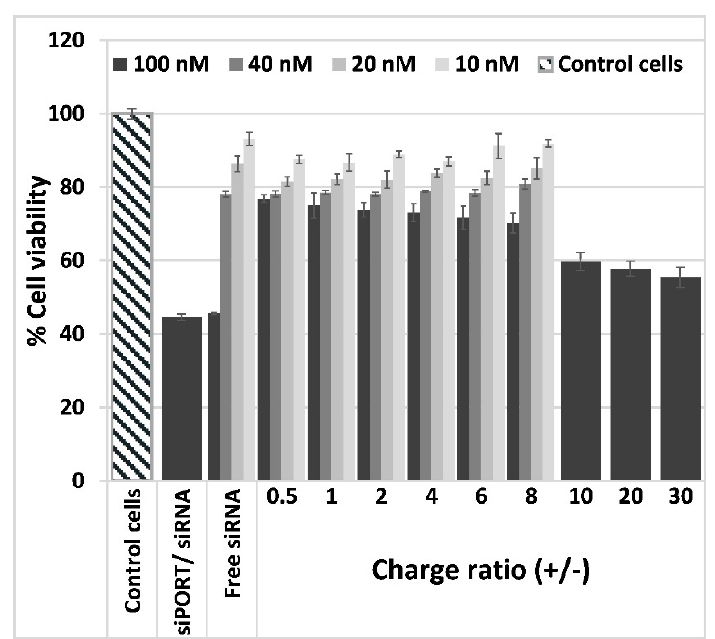
Figure 3. Viability of b.End3 cells exposed for 48 hours to different charge ratios (+/ − ) of Psel-lipo/siRNA lipoplexes (0.5, 1, 2, 4, 6, 8, 10, 20, 30) formed with different siRNA concentrations (10 nM, 20 nM, 40 nM, 100 nM). Data is presented as mean ± S.E.M. of three identical experiments made in